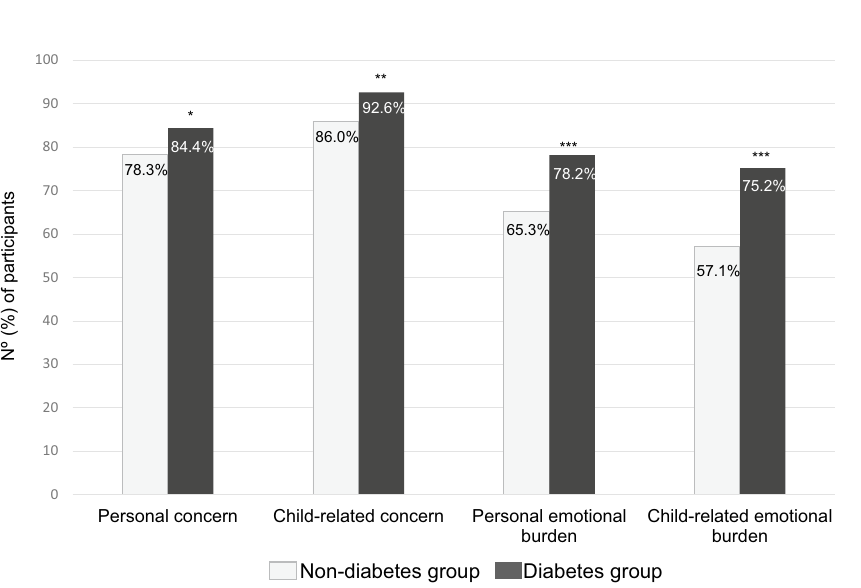
Figure 1. Assessment of pandemic-related emotional burden between the diabetes group and the non-diabetes